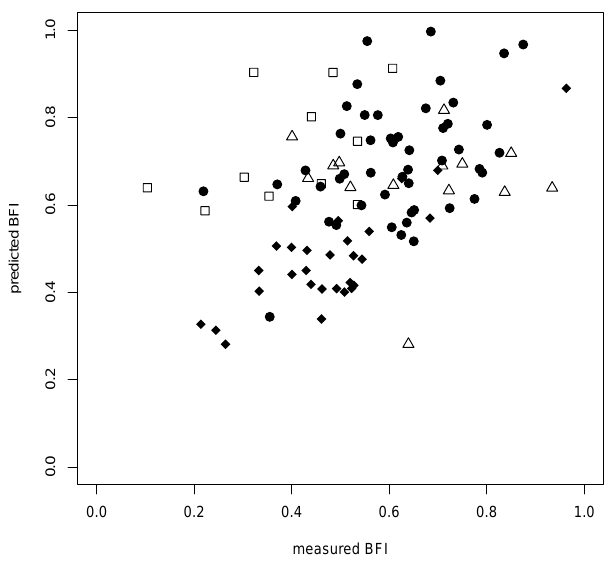
Fig. 4. Geographical location, group association (symbols) and residuals of the BFI predictions (colors) for the 103 catchments evaluated in the study. Residuals were obtained by comparing BFI values calculated from discharge data with prediction based on the reclassified SGDBE and regression coefficients as estimated by Boorman et al. (1995). Symbols are similar to Fig. 3: Trian- gles: catchments governed by major artificial influences (Group A); Squares: catchments with CV of annual BFI > 0.18 (Group B); Rhomboids: remaining catchments in England and Wales (Group C); Circles: remaining catchments outside England and Wales (Group